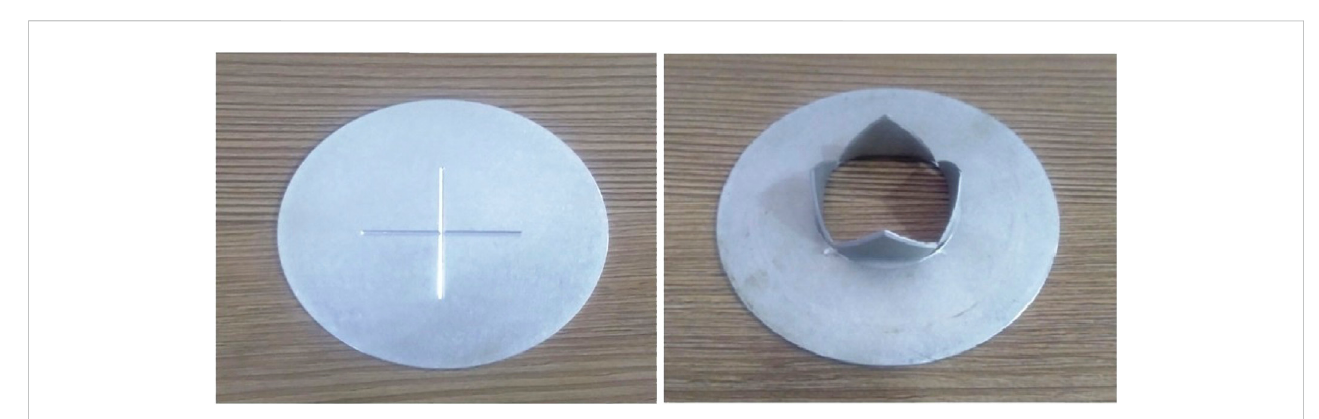
Test specimen after structural